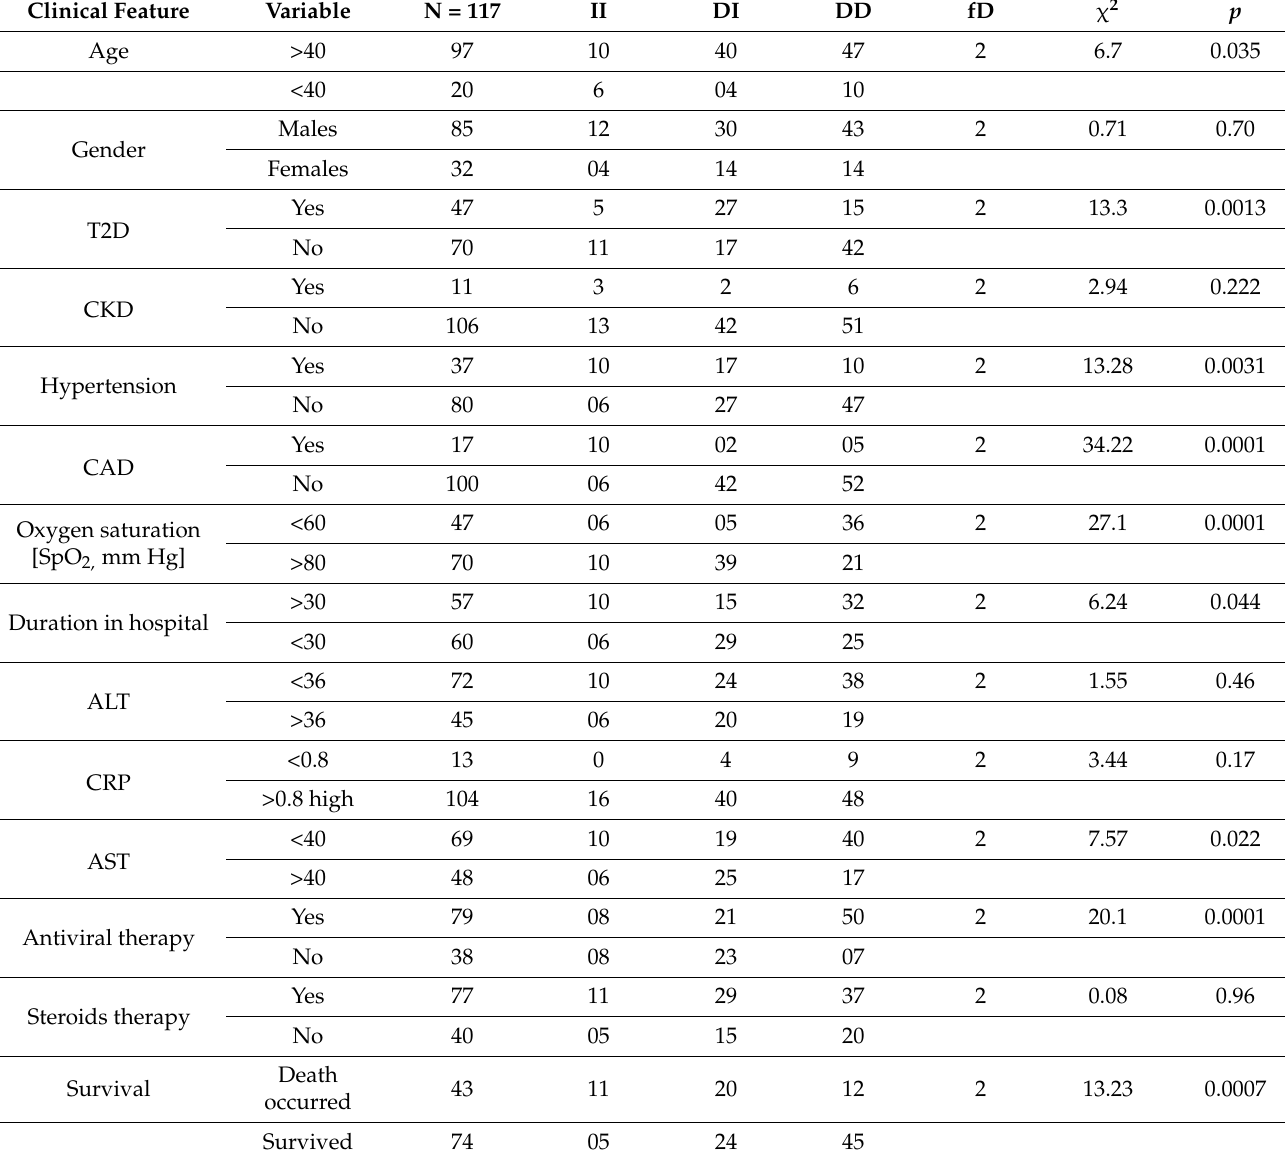
Table 5. Statistical comparisons ( p -values) of ACE2-rs4646994 I/D genotypes with comorbid conditions and some clin- ical parameters with COVID-19 disease severity. T2D—type2 diabetes; CKD—chronic kidney disease; CAD—coronary artery disease; SpO 2 —partial pressure of oxygen; ALT—alanine transaminase; CRP—C reactive protein; AST—aspartate